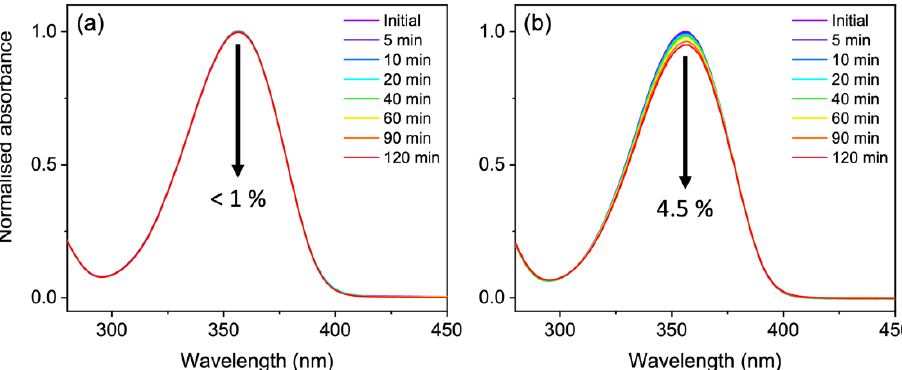
Figure 5. ( a ) UV-visible spectra over 120 min of continuous irradiation at 357 nm of a ~15 μ M usujirene/palythene aqueous solution. ( b ) UV-visible spectra over 120 min of continuous irradiation under a solar simulator of a ~20 μ M usujirene/palythene aqueous solution.